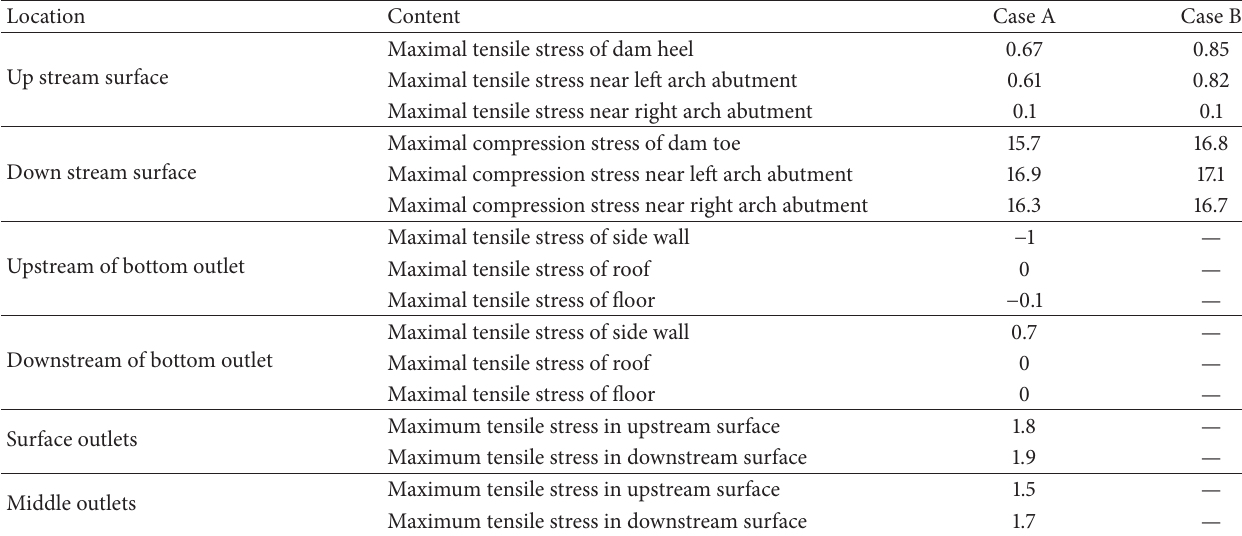
Table 5: Characteristic stresses at various key locations from both the analysis cases A and B (Unit: